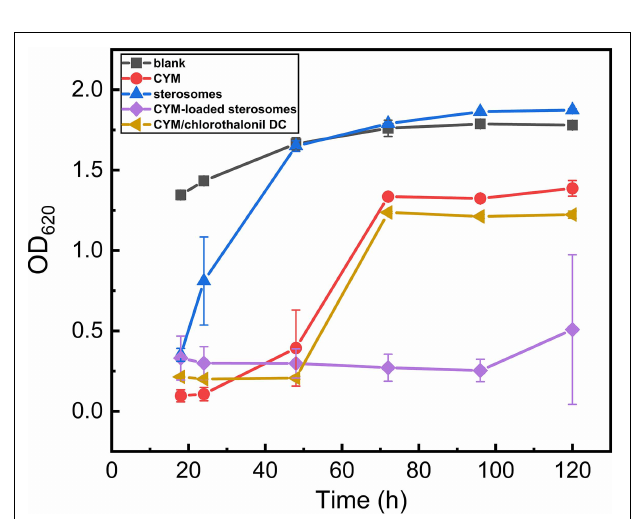
medium, which could be caused by the electrostatic interactions between yeast cells and sterosomes. This is because of the negative charges on the surface of the cell membrane, which facilitates the complexation of cationic sterosomes to accumulate on the cell